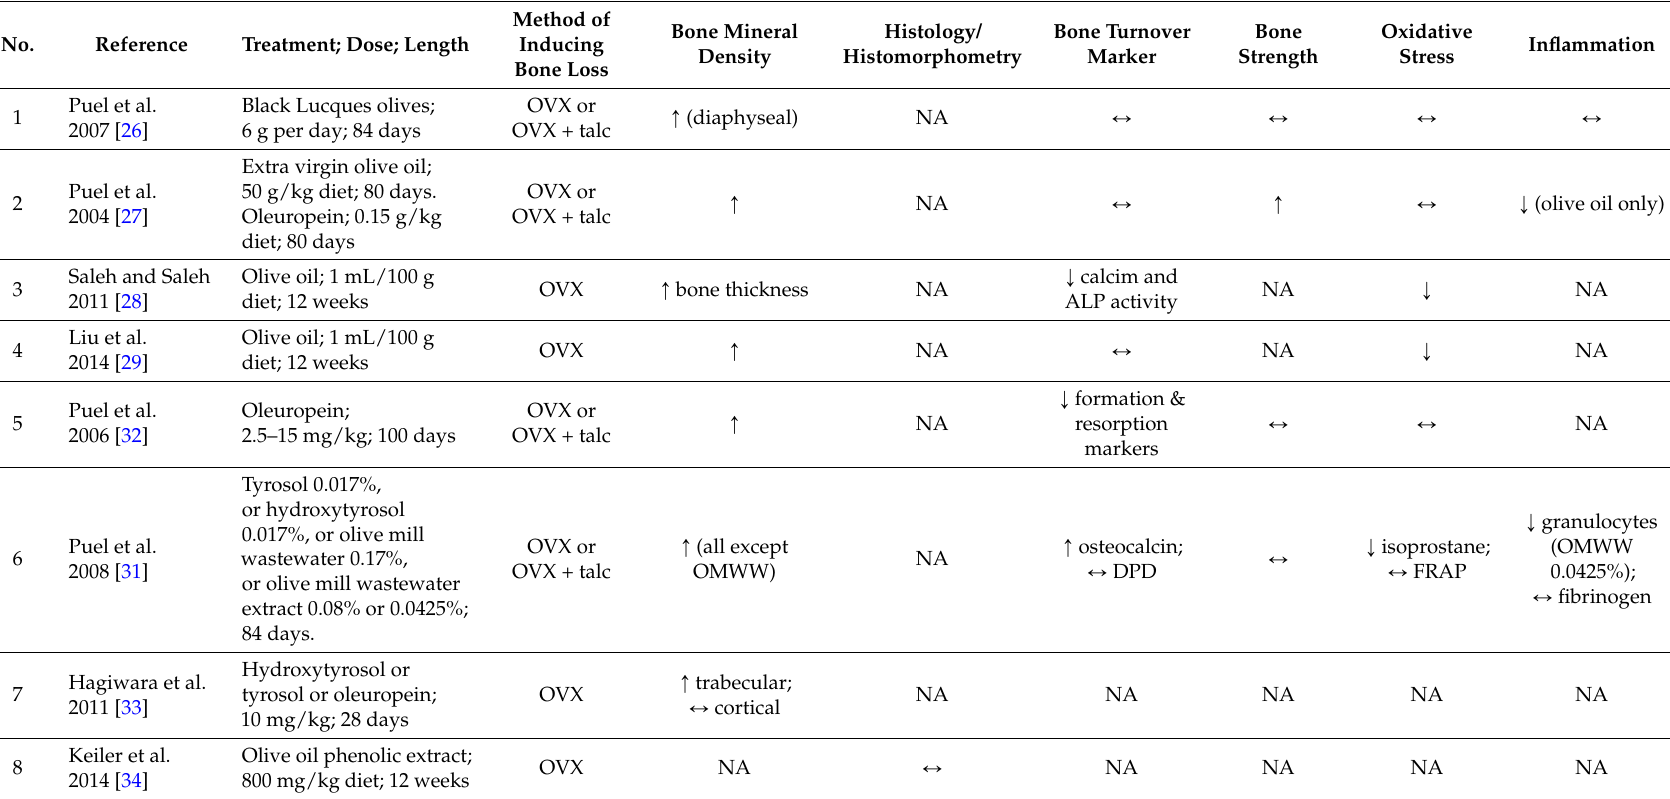
Table 1. Animal studies on the bone protective effects of olives, olive oil and its